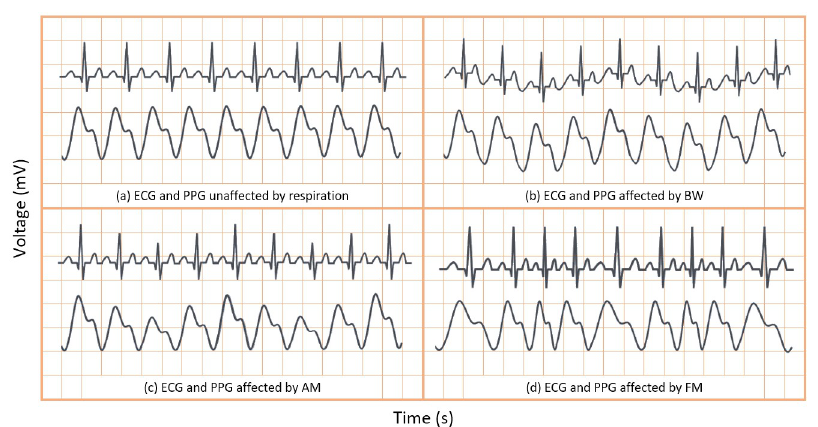
Fig 1. Sample ECG and PPG signals with and without effects of respiratory modulation. (A) unaffected by respiratory modulation. (B) affected by baseline wander. (C) affected by amplitude modulation. (D) affected by frequency